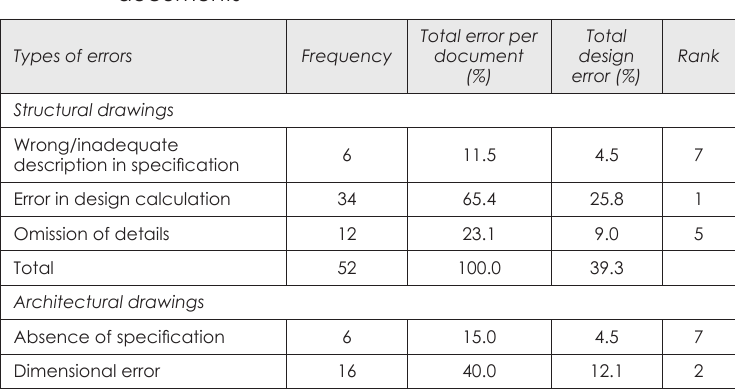
Table 7: Design errors that led to variation based on design